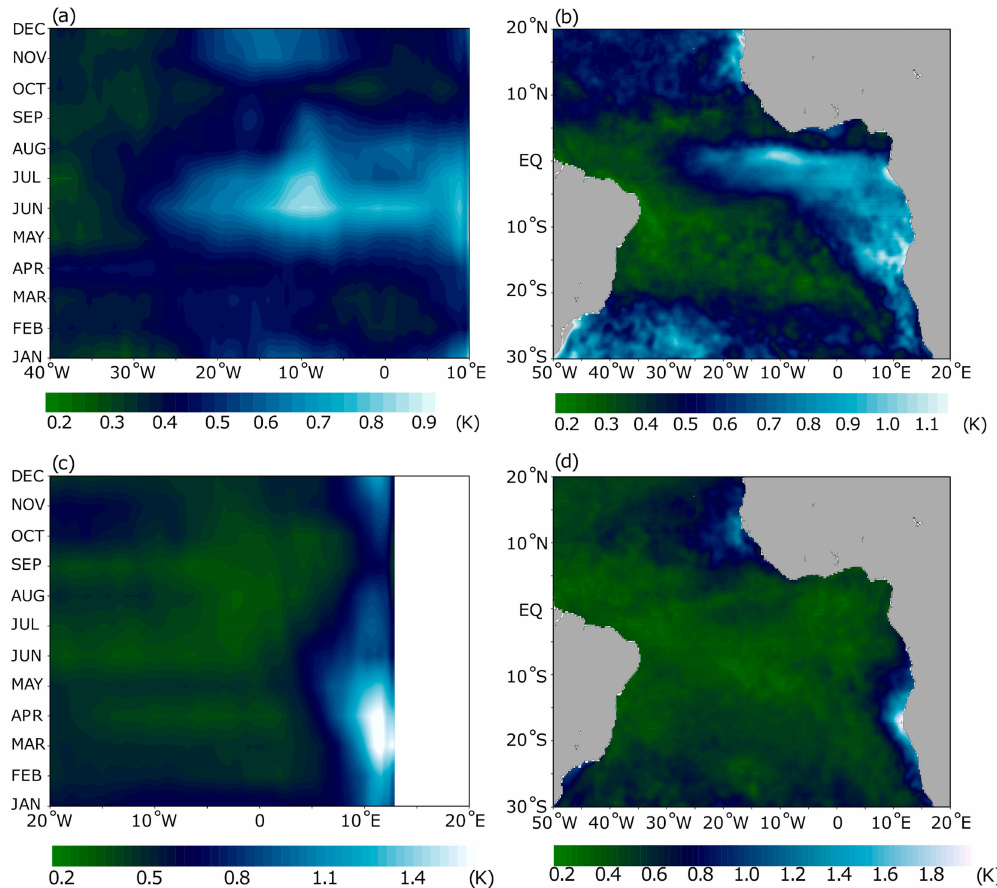
Figure 3. ( a ) and ( c ) seasonal cycle of the observed sea-surface temperature (SST) (OISST, 1979–2010) one standard deviation in the Equatorial (averaged between 3 ◦ S and 3 ◦ N) and Angola–Benguela Frontal Zone(averaged20 ◦ S–14 ◦ S).TheobservedSSTstandarddeviationin( b )Juneand( d